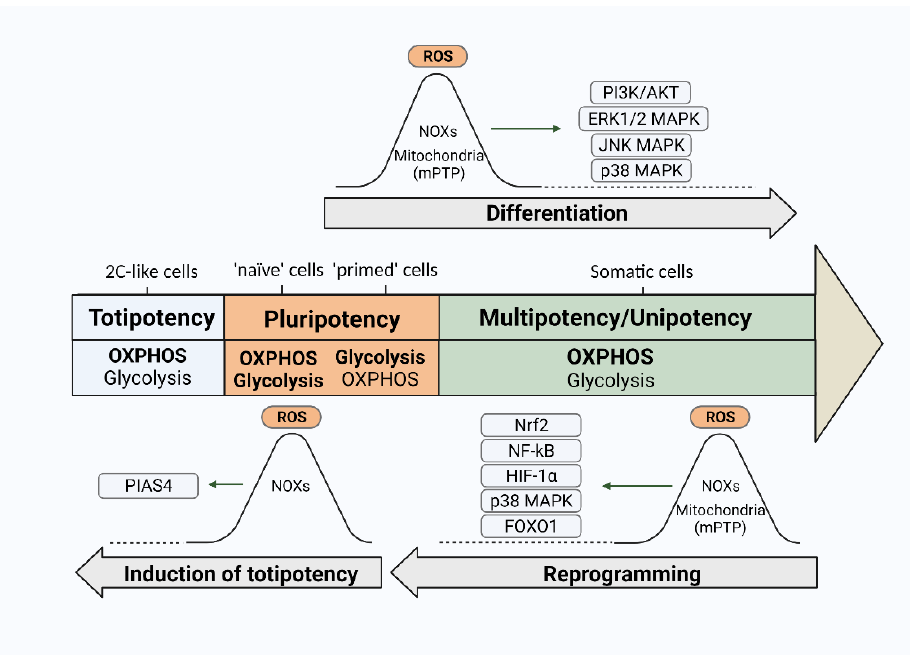
Figure 3. Redox signaling pathways participating in the regulation of cell differentiation, induction of pluri- and totipotency. The onset of these programs is accompanied by the early short-term ROS level increase, which mediates/stimulates the rearrangements of cell phenotypes and large-scale metabolic shifts. These shifts determine the prevalent energy production pathway corresponding to each cell phenotype. ROS, reactive oxygen species; NOX, NADPH oxidase; MP, mitochondrial pore, OXPHOS, oxidative phosphorylation pathway; PI3K, phosphatydylinositol-4,5-bisphosphate 3-kinase; AKT, protein kinase B; MAPK, mitogen-activated protein kinase; ERK, extracellular signal-related kinases; JNK, c-Jun N-terminal kinases; p38, p38 kinase; MAPK, mitogen-activated protein kinase; Nrf2, nuclear factor erythroid 2-related factor 2; NF-kB, nuclear factor kappa-light-chain-enhancer of activated B cells; HIF-1α, hypoxia-inducible factor 1α; FOXO1, forkhead box protein O1; PIAS4, protein inhibitor of activated STAT 4, 2C-like cells, transient cell population within PSC cell cultures that expresses high levels of transcripts found in two-cell (2C) embryos.